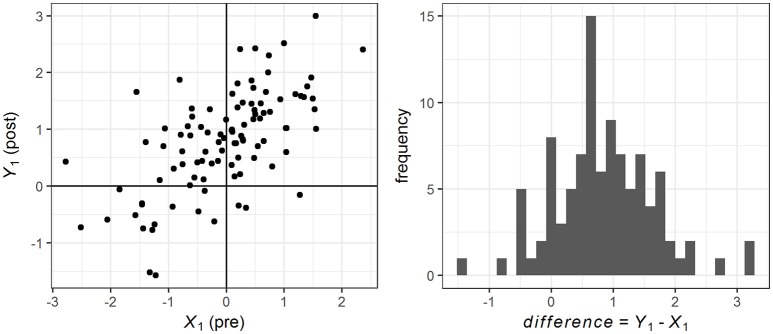
Pre, post and difference scores for one sample of n = 100, with δexp = 1.2, ρpre−post = 0.7, and normal distribution. Note that the amount of change is different for every individual.